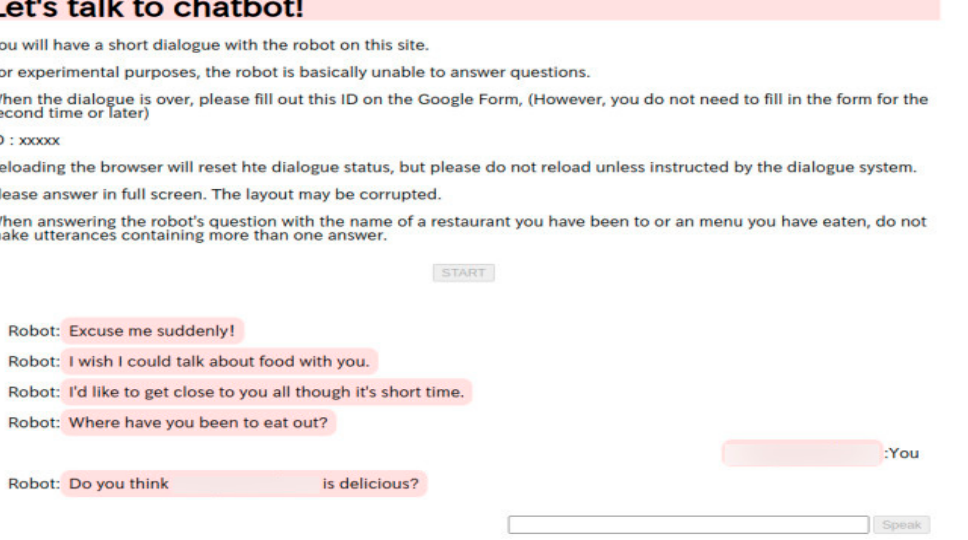
Figure 6. Chat interface. Note: Mosaic is applied to the part where the restaurant name is identified. Japanese was used for the experiment, and this image has been translated into